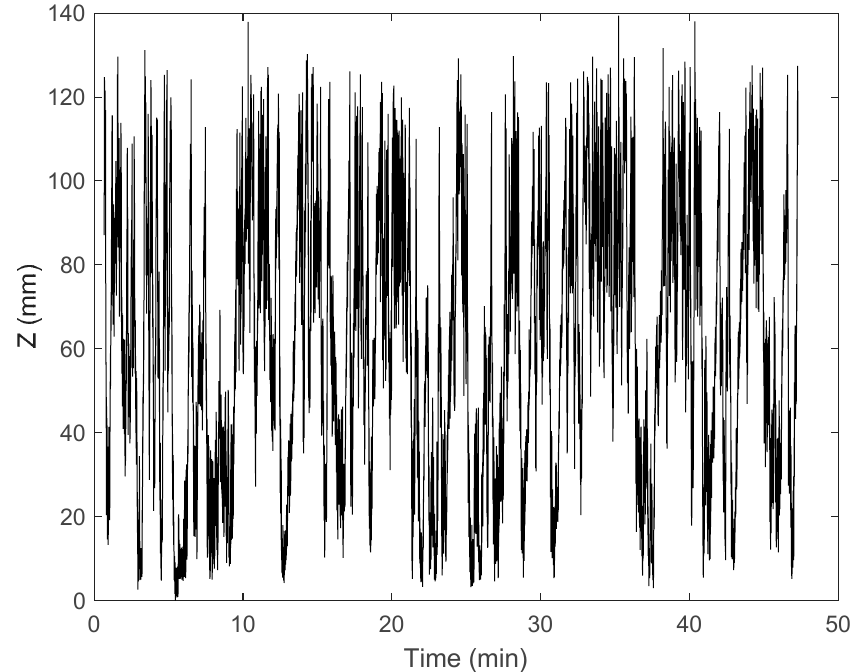
Figure 2. Example for a PEPT raw dataset representing the tracer particle position along the Z direction (vertical axis) over time for the impeller speed of 300 rpm.